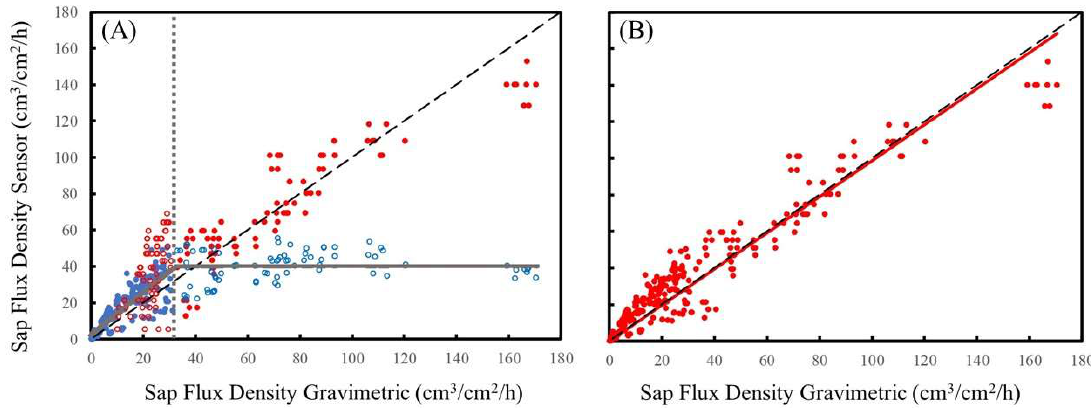
Figure 4. An example of posteriori analysis for the DMA. ( A ) The piecewise linear regression analysis (solid grey line) with a breakpoint (dotted grey line) at 32.540 cm 3 /cm 2 /h. Where X <breakpoint then HRM/SRFM data is selected for the DMA, and where X >breakpoint then Tmax data is selected for the DMA, as displayed in ( B ). The solid red line in ( B ) is the linear regression of the DMA against gravimetric sap flux density. The black dashed line is the 1:1 relationship. Slopes and R 2 results are displayed in Table 2. Table 2. Piecewise linear regression results of sap flux density ( J s ) estimated from the sap flow sensor method against gravimetric J s and the maximum observed (Max. Obs.) and minimum observed (Min. Obs.) heat velocity ( V h ) measured for each method. A complete table comparing all methods against gravimetric sap flow is found in the Supplementary Materials. Slope was determined from the linear regression curve, and Error is based on the deviation of this slope from 1; RMSE is the root mean square error of the linear regression (smaller values indicate a more accurate model); n is sample size; V h is heat velocity.